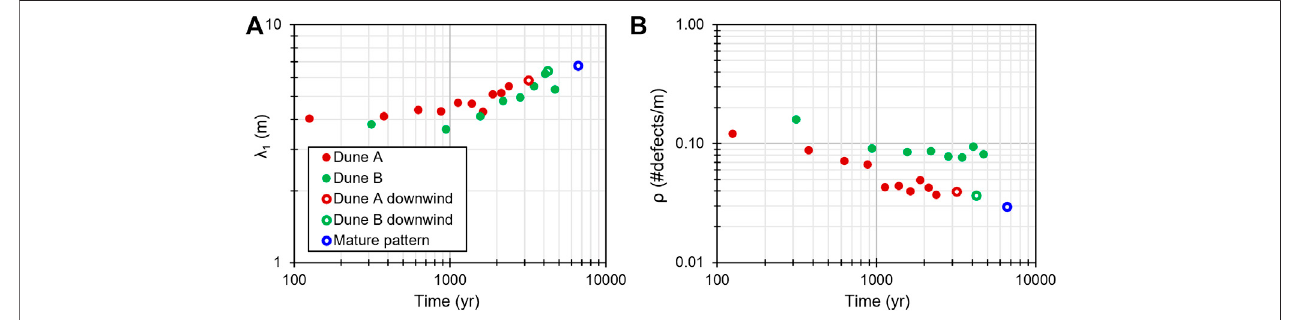
FIGURE 10 | (A) Mean bedform spacing and (B) defect density with estimated age in the wakes, downwind of each dune, and the mature pattern (see Figure 4 ).